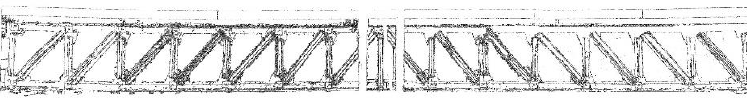
Figure 16. Distribution of feature points on test beam’s surface.